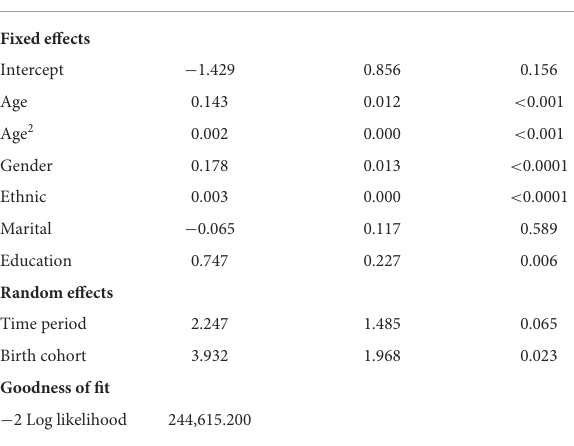
transmission via blood. In 1996 and 1997, China proposed TABLE 3 Estimation of age-period-cohort effect on the trends of human immunodeficiency virus (HIV) infection via sexual transmission during 1995–2020 in Hubei,